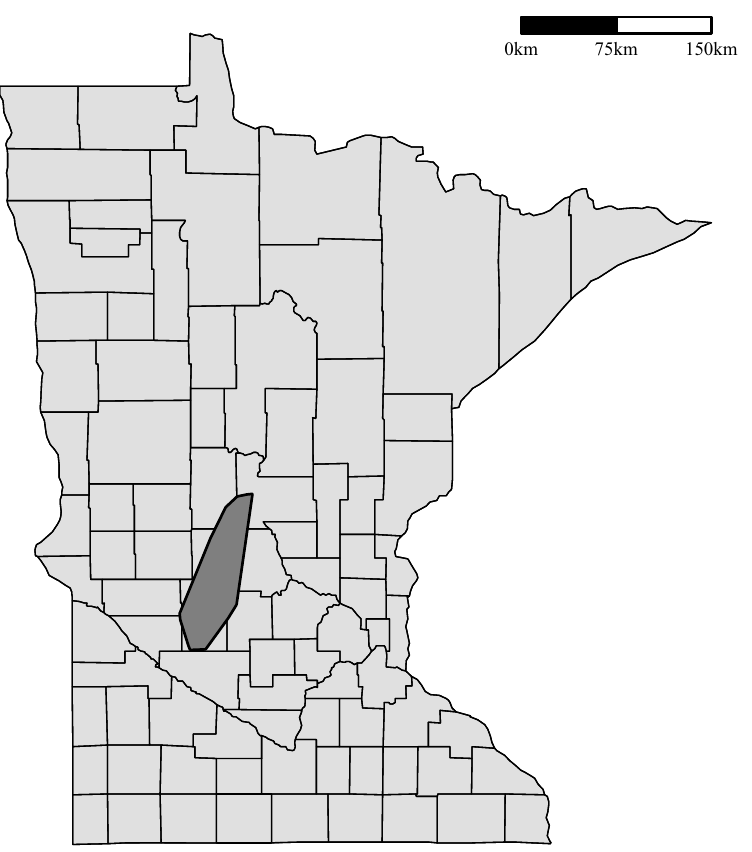
Fig 5. Minnesota risk map. The shaded region encapsulates the primary risk area for HPAI spread in Minnesota with broiler type premises excluded. The risk area was identified by the premises with basic reproduction numbers greater than one. See text for